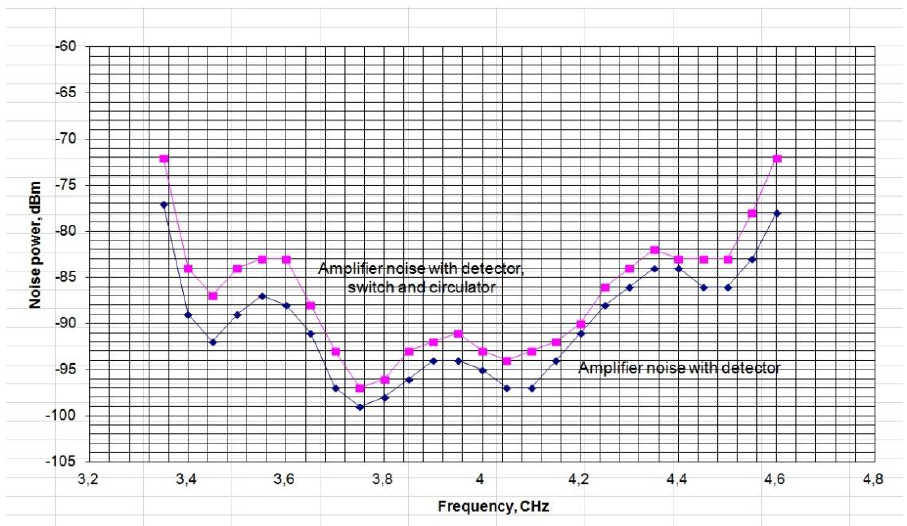
Fig. 4. The result of measuring the noise level of radiometer